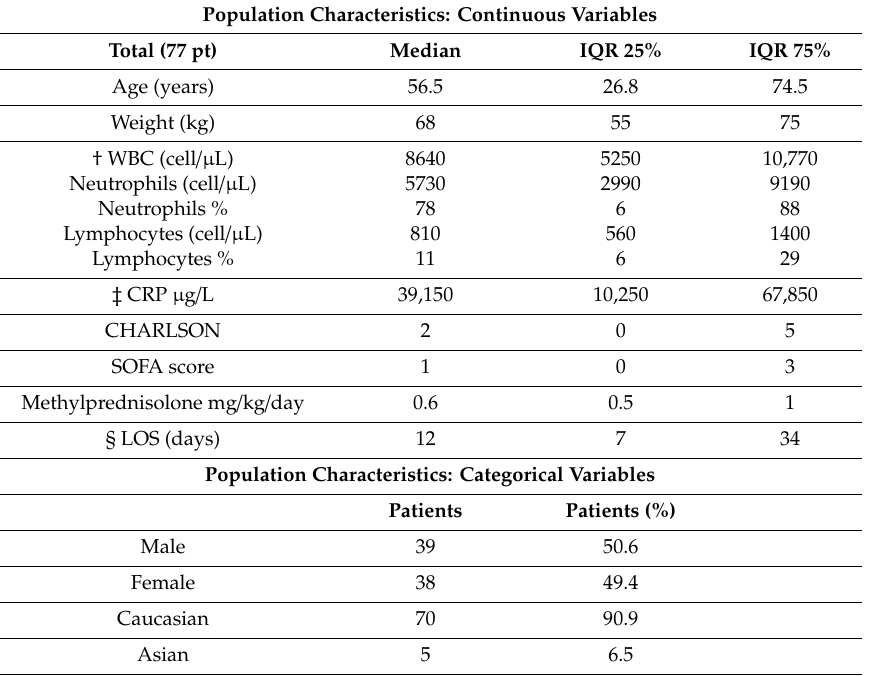
Table 1. Population